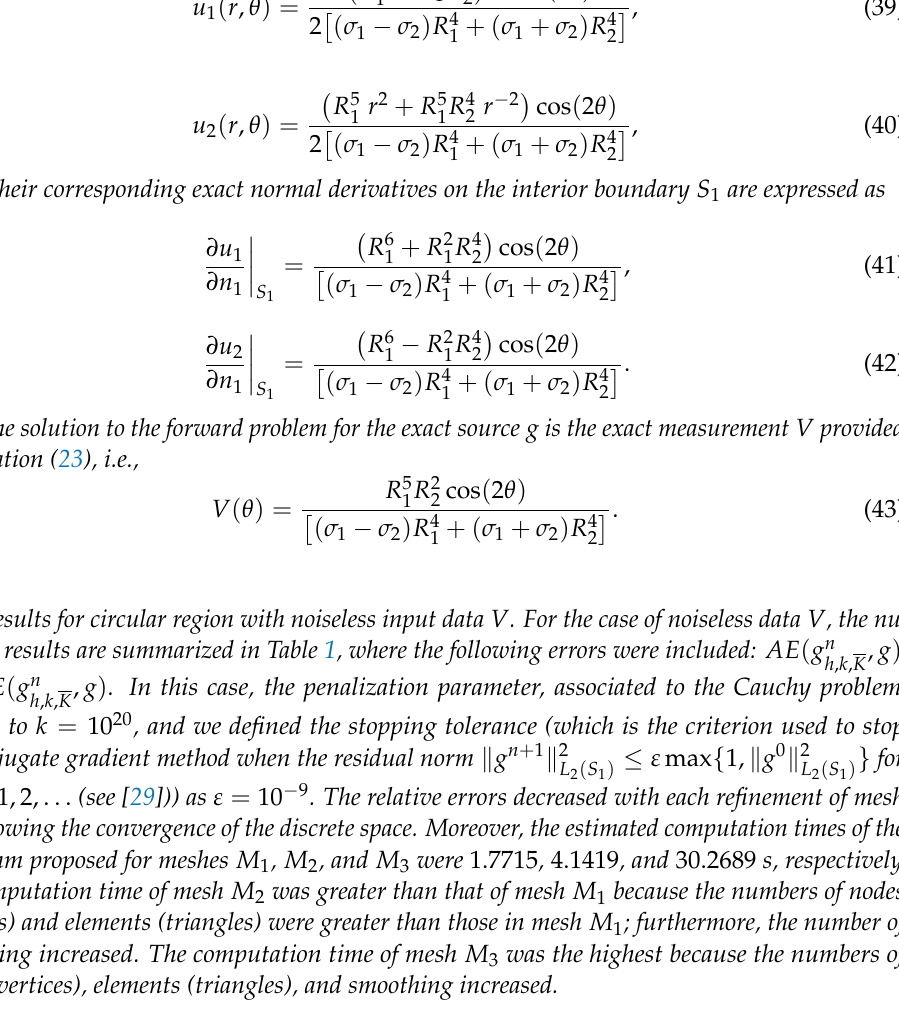
Table 1. Convergence of numerical results for circular region with noiseless data V , with k = 10 20 and ε = 10 − 9